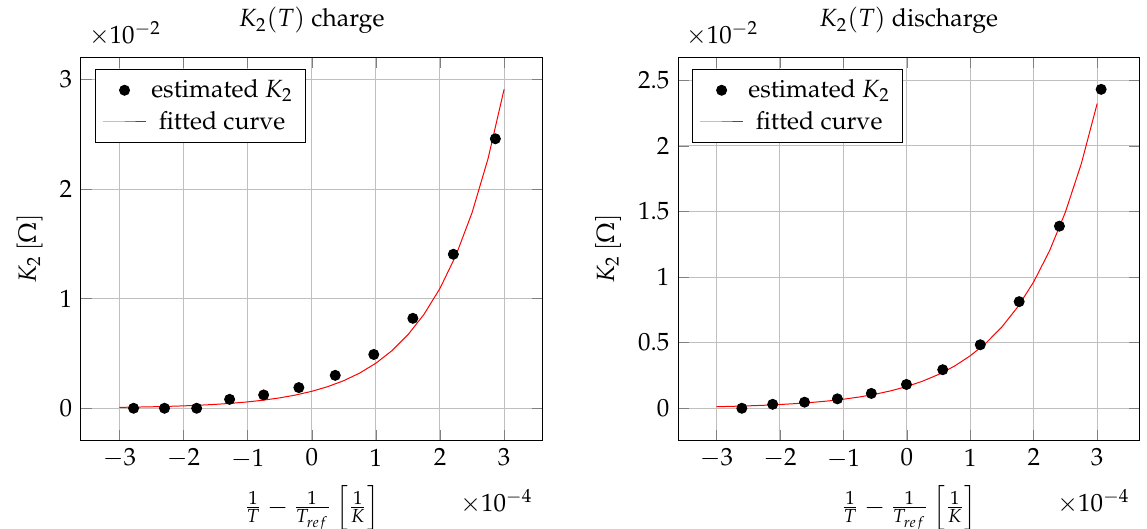
Figure 7. Estimation of the temperature dependency of K 1 .